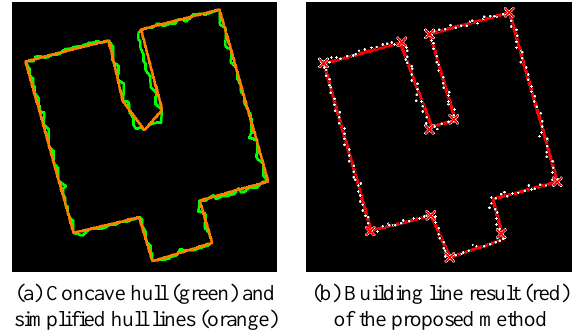
Figure 11. Comparison of the concave hull, a simplified concave hull, and adaptive RanSAC